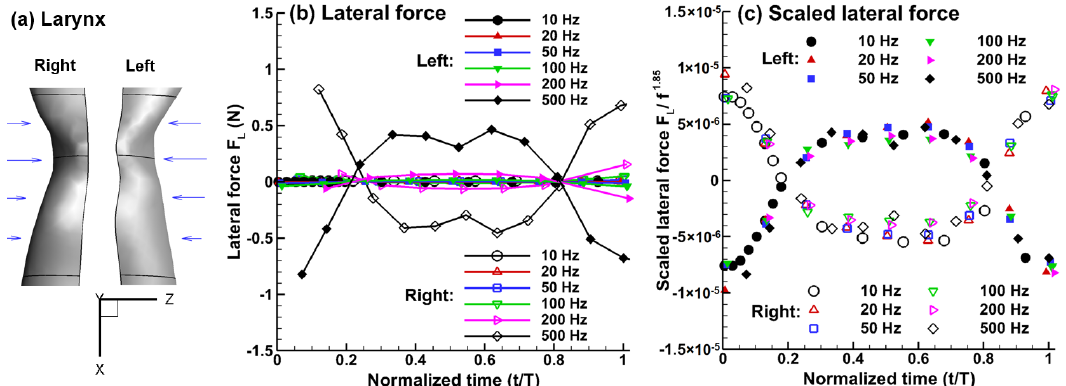
Figure 5. Pressure forces acting on the glottal walls: ( a ) diagram of the normal forces acting on the right and left lateral walls, ( b ) the pressure force in the first and third quartiles of a vibration cycle facilitates the glottis motion (self-sustaining), while that in the second and third quartiles work against the motion (anti-self-sustaining). ( c ) The pressure force has a nonlinear relationship with the vibration frequency ( f 0 1.85 ).